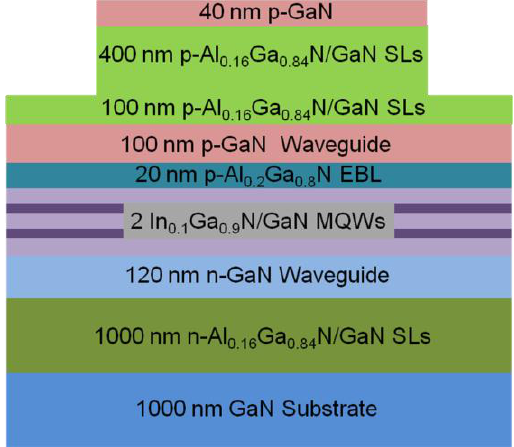
Figure 1. The schematic diagram of c -plane GaN-based LDs